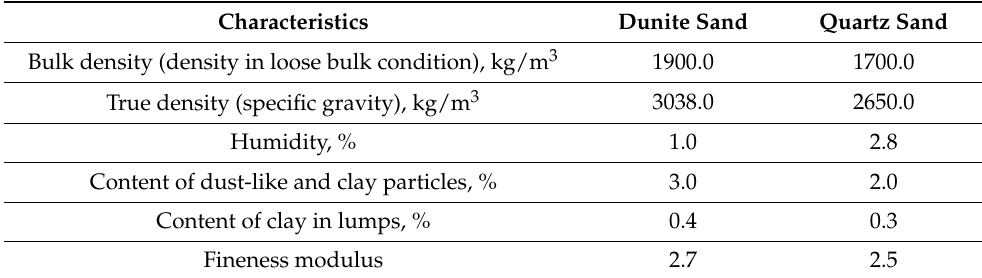
Table 3. Physical and mechanical characteristics of the